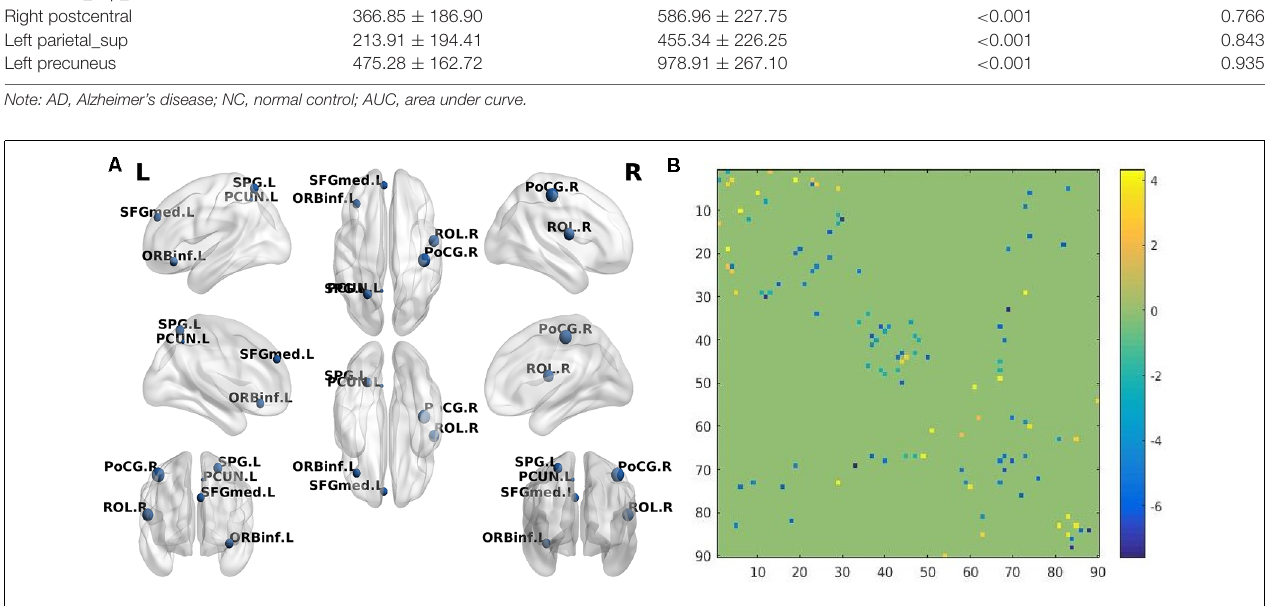
FIGURE 1 | (A) The brain regions (nodes) visualized by BrainNet Viewer (NKLCNL, Beijing Normal University) demonstrate significantly different betweenness centrality (BC) when Alzheimer’s disease (AD) was compared with normal control (NC; p < 0.001, FDR-corrected). ORBinf.L: left frontal_inf_orb; ROL.R: right rolandic_oper; SFGmed.L: left frontal_sup_medial; PoCG.R: right postcentral; SPG.L: left parietal_sup; PCUN.L: left precuneus. (B) The structural connectivity alterations between the AD and NC groups. Horizontal axis and vertical axis respectively represent 90 brain regions in the automated anatomical labeling (AAL) template. The dots in different locations in the matrix represent the structural connectivity between the two different brain regions identified by the horizontal axis and vertical axis. The colors of the dots represent structural connection strength, quantified by the values on the right of the color bar. The dot color with a positive value represents increased structural connection between the two brain regions in the AD group, compared with the NC group, while the dot color with a negative value represents a decreased structural connection.